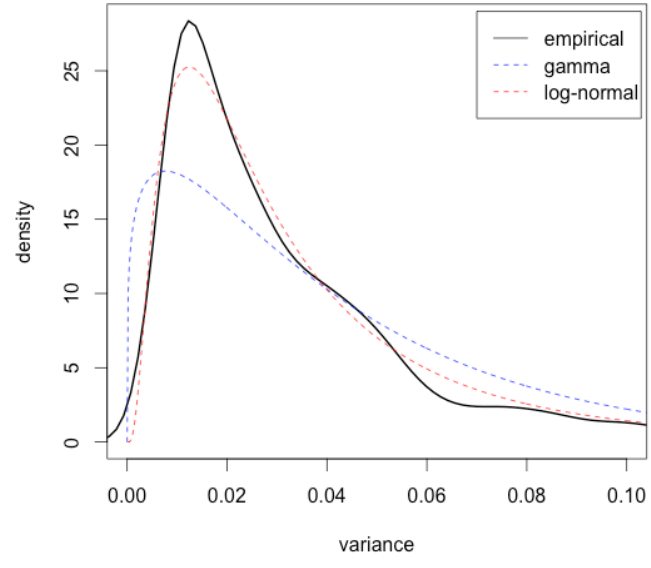
Figure 1. Estimated empirical density of the annualized measured instantaneous S&P500 variance (4552 daily observations 1996–2013 using Equation (1)) together with fitted log-normal and gamma